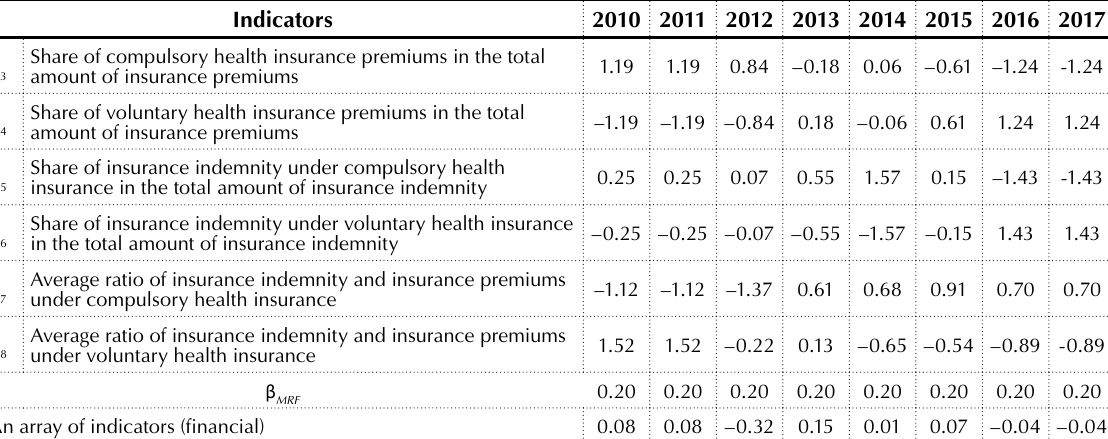
Table 7. Calculation of the socio-economic potential of health insurance/an array of indicators of the management of financial resources of health insurance companies of socio-economic potential (specified values)